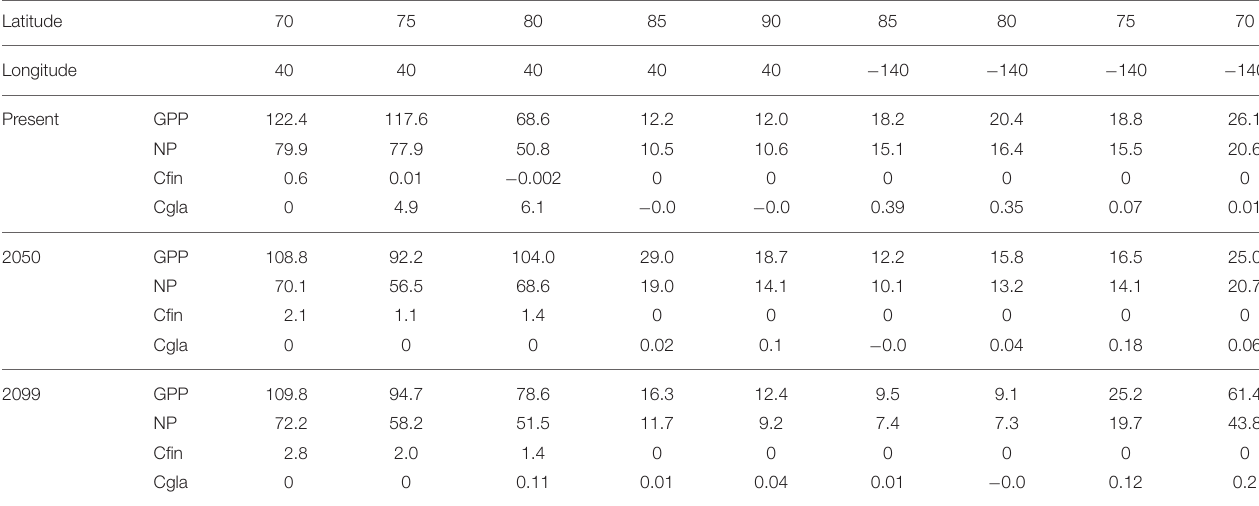
TABLE 3 | Annual Gross Primary Production (GPP), New Production (NP) and the production of Calanus finmarchicus (Cfin) and Calanus glacialis (Cgla) (g C m − 2 y − 1 ) at the various latitudes along transect A from the southern Barents Sea to the Beaufort Sea (see Figure 2). Latitude